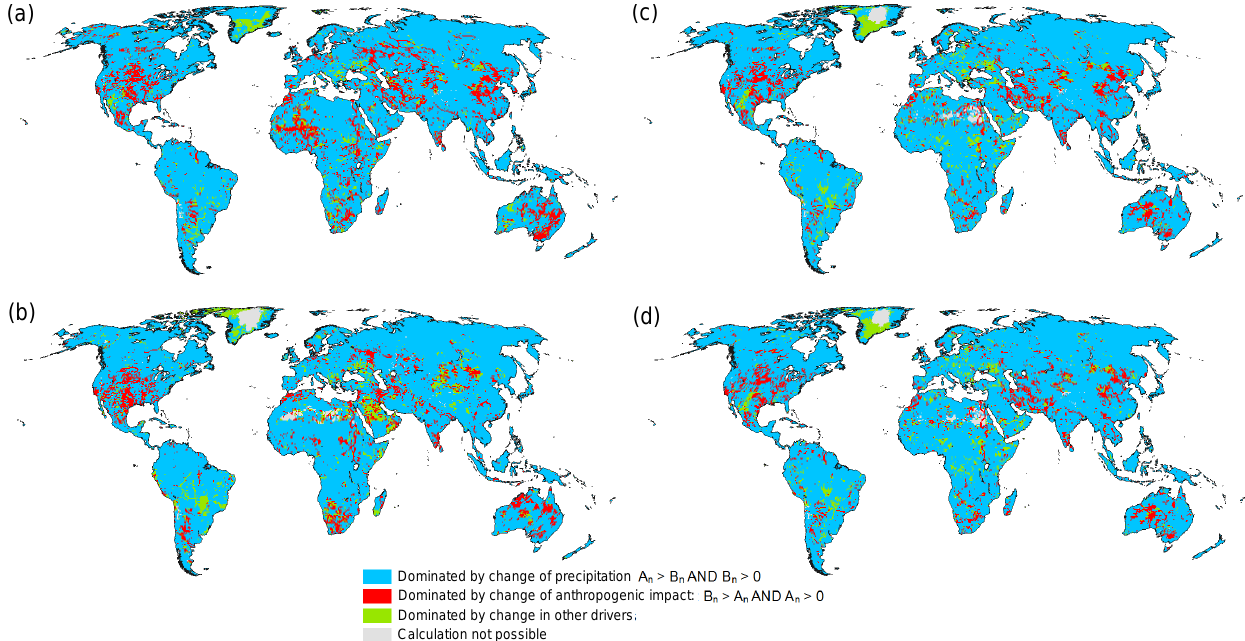
Figure 5. Relative dominance of drivers of change of long-term average Q between 1911–1940 and 1941–1970 (Sect. 2.4.2). Blue indicates that change in P is more dominant than change in anthropogenic impact due to water abstraction and dam construction, red indicates the opposite. In green areas, other drivers are dominant. In grey areas, a calculation is not possible as the denominator of indicators A n and B n is zero (no change in long-term average Q ). Results are shown for WaterGAP as driven by the meteorological forcings GSWP3 (a) , PGFv2.1 (b) , WFDEI_hom (c) , and WFD (d)